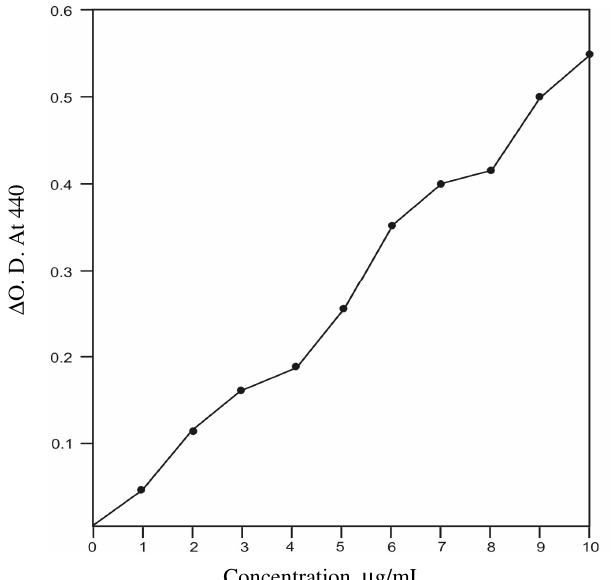
Figure 1. Production of singlet oxygen by benzathrone 1-10 µg/mL upon sunlight 15 min as measured by recording a decrease in UV-absorption of RNO (32 ± 0.2 x 10 -5 M in 0.01 M phosphate buffer with 20% DMF, pH 7) containing HIS (1x10 -2 M) as a selective acceptor of 1 0